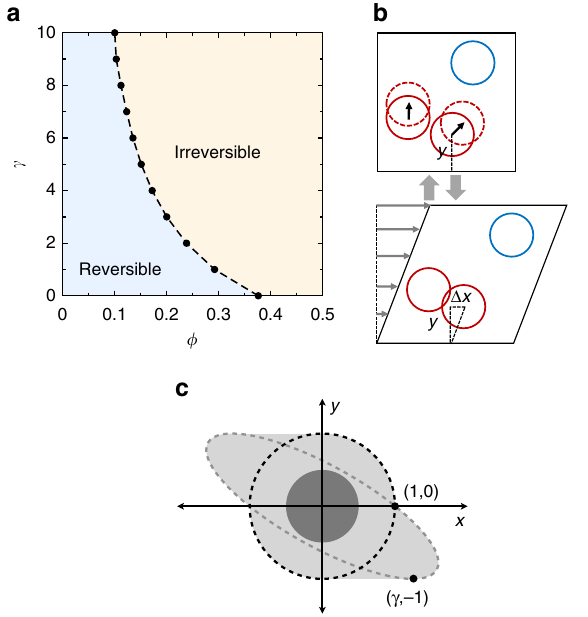
Fig. 1 Sheared non-Brownian suspension model after ref. 6 . a Phase diagram showing reversible steady states at low concentration, ϕ and strain amplitude, γ . Outside this region, a fi nite fraction of particles collide during each cycle in the steady state. Dashed line: Critical phase boundary. Data show the largest γ where we obtain a reversible state in simulations with L = 200 d . b Simulation algorithm. In each shear cycle, particles are displaced a horizontal distance Δ x = γ y and then returned to their initial positions. Particles that overlap (red) are given random kicks, to simulate local irreversibility due to collisions. c Interaction region around a particle. A second particle with its center anywhere inside the dashed circle will overlap with the particle at the origin (shown as a dark circle); they would both receive a random kick. Shearing the system expands the interaction region to the entire shaded area (shown for one value of γ ), which contains the points that are covered by continuously shearing the dashed circle up